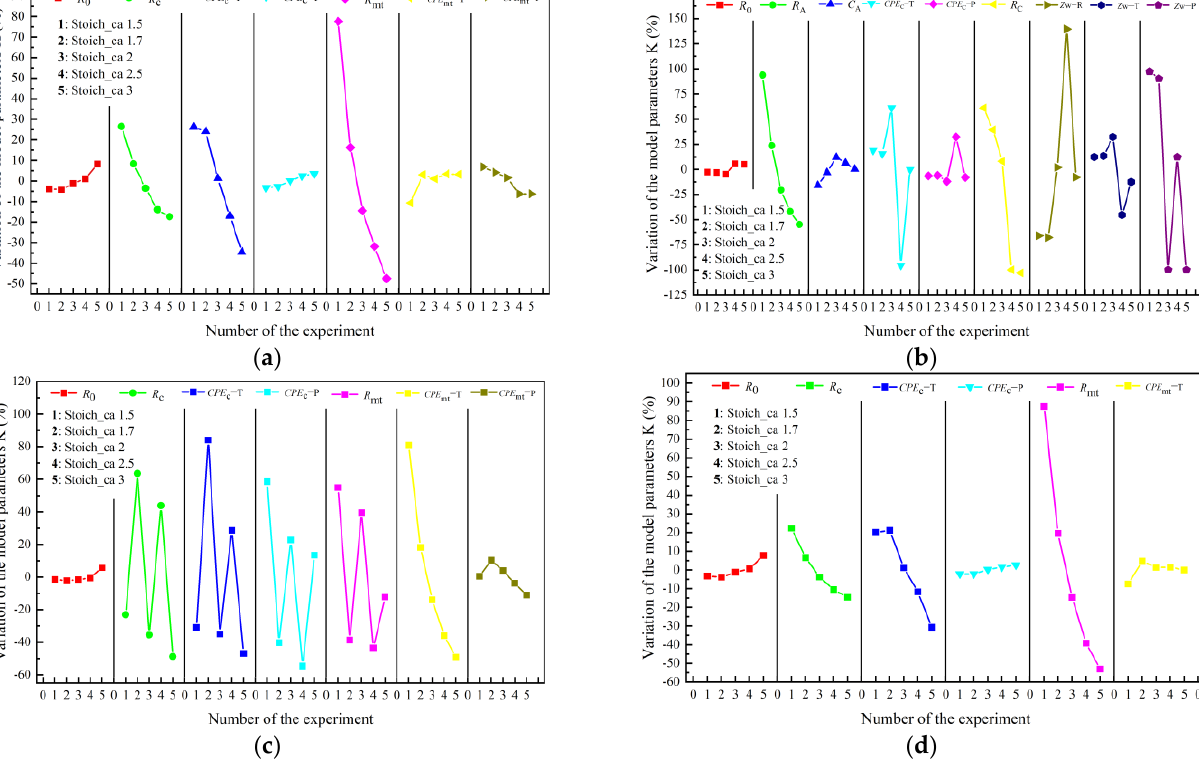
Figure 8. The Changing trend of the model parameters under different air stoichiometry: ( a ) the parameter variations of model A; ( b ) the parameter variations of model B; ( c ) the parameter variations of model C; ( d ) the parameter variations of model D.